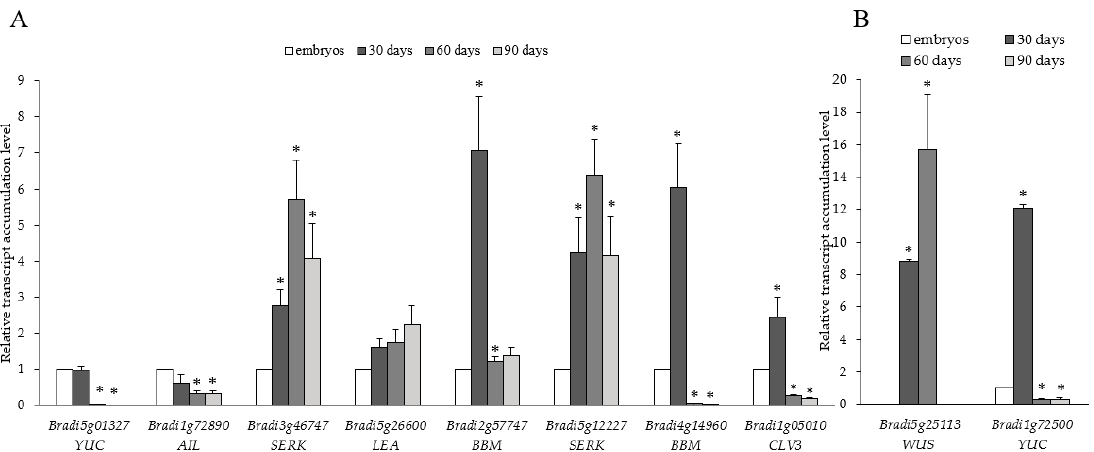
Figure 5. Relative transcript accumulation levels of ( A ) YUC (Bradi5g01327), AIL (Bradi1g72890), SERK (Bradi3g46747 and Bradi5g12227), LEA (Bradi5g26600), BBM (Bradi2g577747 and Bradi4g14960), CLV3 (Bradi1g05010) , and ( B ) WUS (Bradi5g25113) and YUC (Bradi1g72500) genes on the 30th, 60th, and 90th day of cultivation. The relative transcript accumulation levels were normalised to an internal control ( AK437296 , a gene encoding ubiquitin) and calibrated to the control (explants, zygotic embryos); *: value is significantly different from the control (Student’s t -test, p < 0.05; n = 3 ± SD). Ten cell cycle-related genes have mostly similar patterns of transcript accumulation. CYCD3 ( Bradi3g58300 ), CYCA3 ( Bradi1g14820 ), CYCB1 ( Bradi2g52760 ), CDKPK ( Bradi1g54570 ), CDKB2 ( Bradi3g40200 ), WEE ( Bradi3g03112 ), and CYCD4 ( Bradi4g32556 ) transcript levels were the highest in 30-day-old calli (Figure 6). Then, the levels decreased on the 60th and 90th day. Unlike other cell cycle-related transcripts, CDKA ( Bradi3g02270 ) and CDKD ( Bradi2g26510 ) showed their highest levels on the 60th and 90th day. The highest relative change in transcript level among all the cell cycle-related genes analysed was for CDKB1 ( Bradi4g25980 ) (Figure 6B), whose expression increased from the 30th to 60th day and was ten-fold higher on the 60th day of culture compared to the embryos. However, CDKB1 transcripts then dramatically decreased on the 90th day.